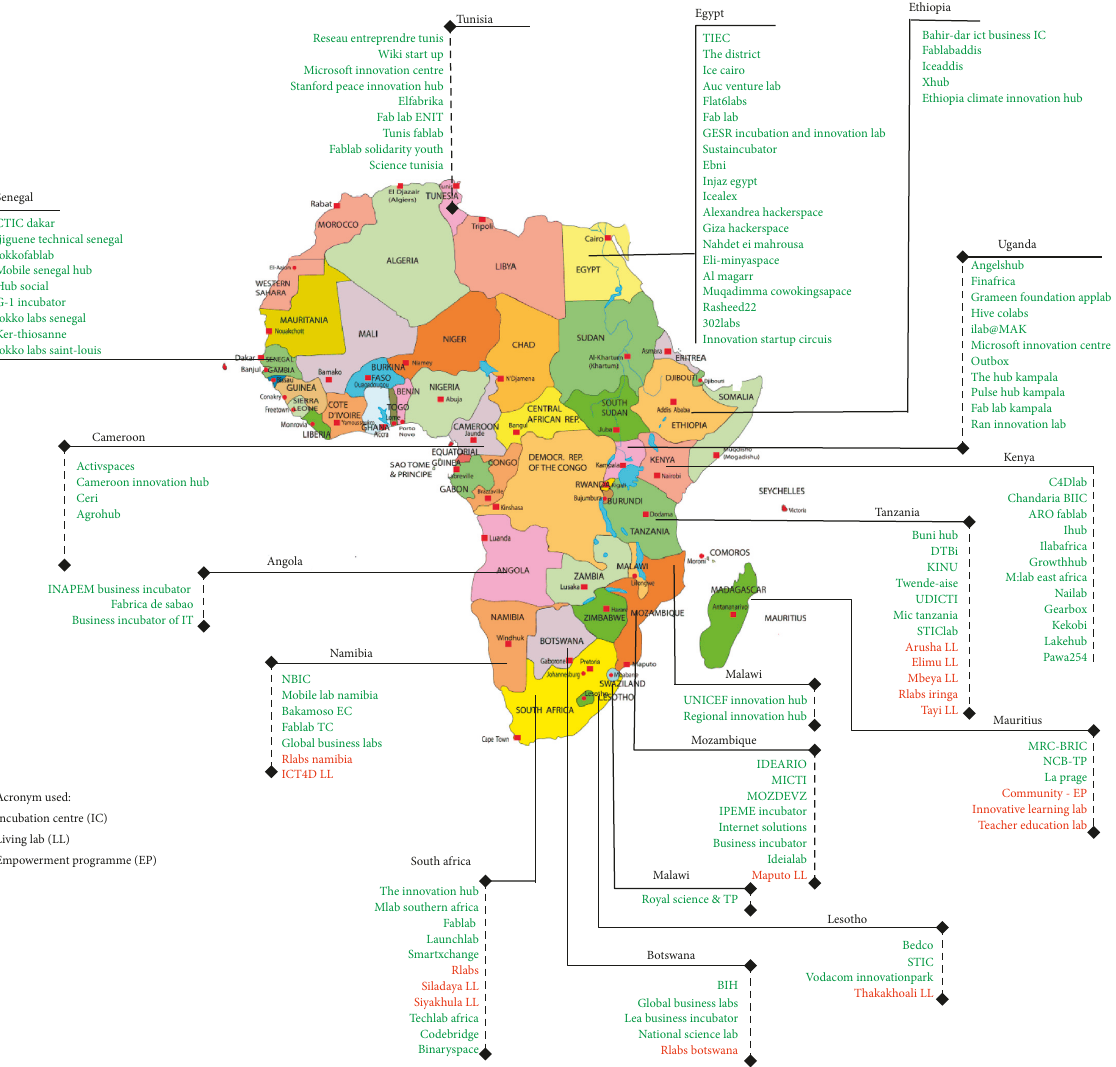
Figure 10: The landscape of living labs and innovation spaces in